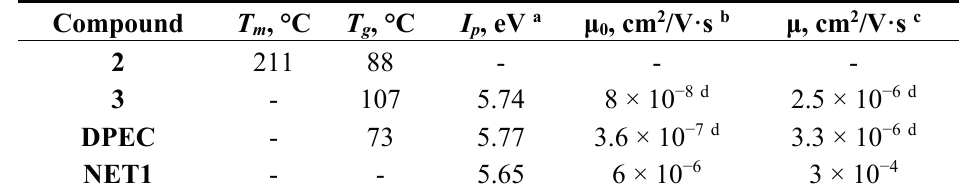
Table 1. Thermal and photoelectrical properties of compounds 2 , 3 , DPEC , and cross-linked layer NET1 .